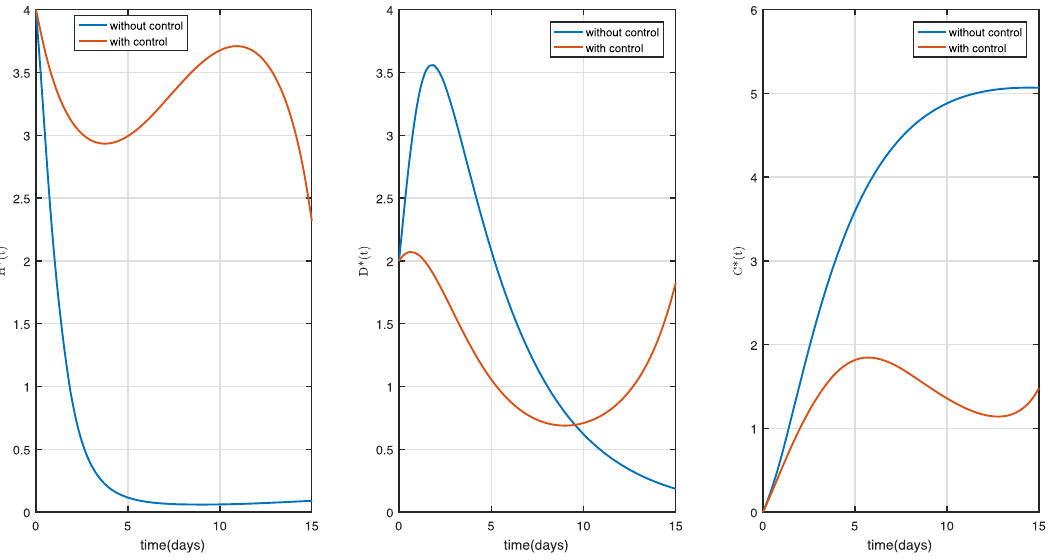
Figure 7: Optimal behavior of the banking system